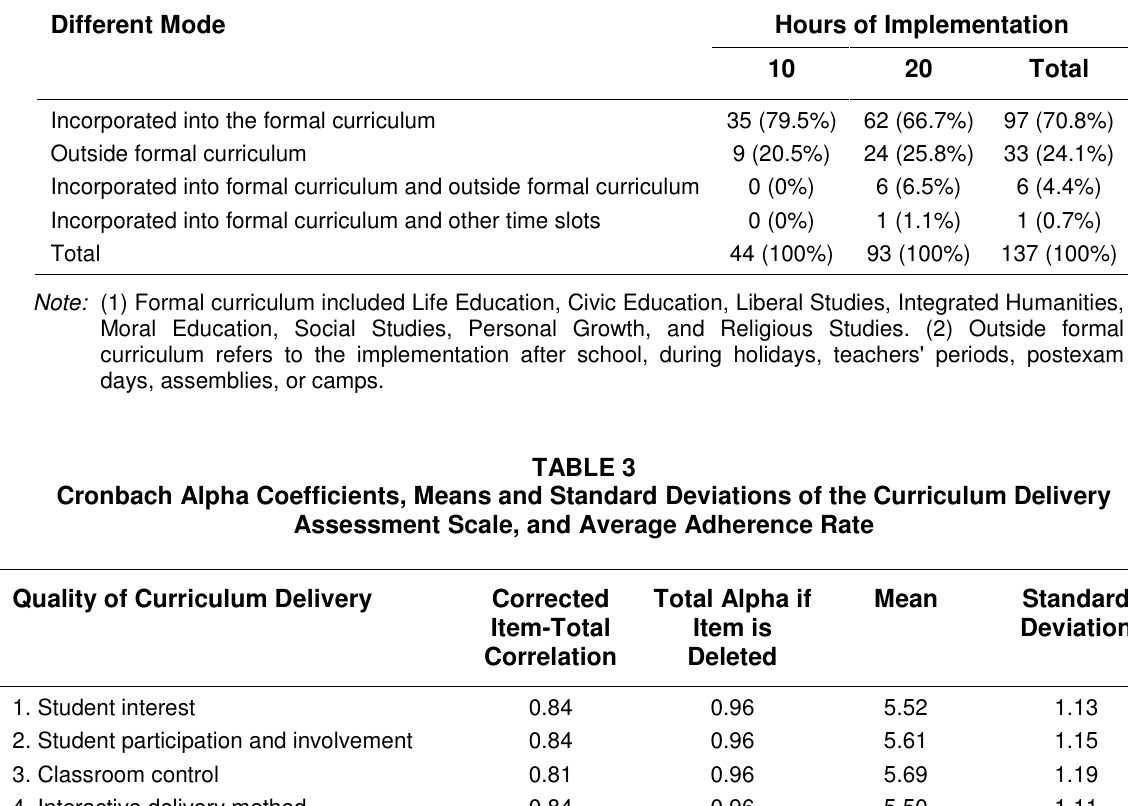
The Percentage of Observed Tier 1 Program Units Implemented in Different Modes for Schools Adopting 10 and 20 Hours of Implementation